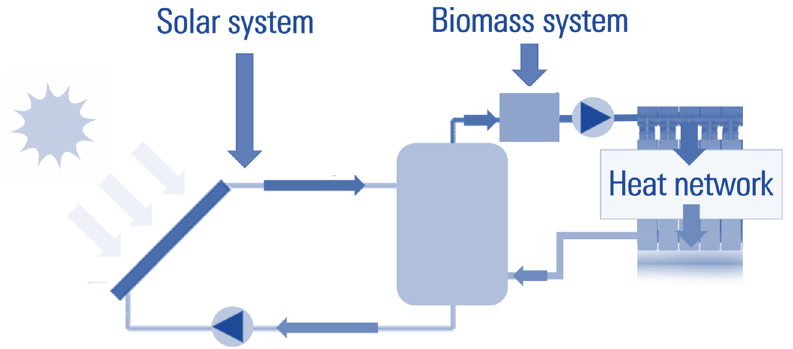
Figure 3. The base structure of the hybrid-modular system.